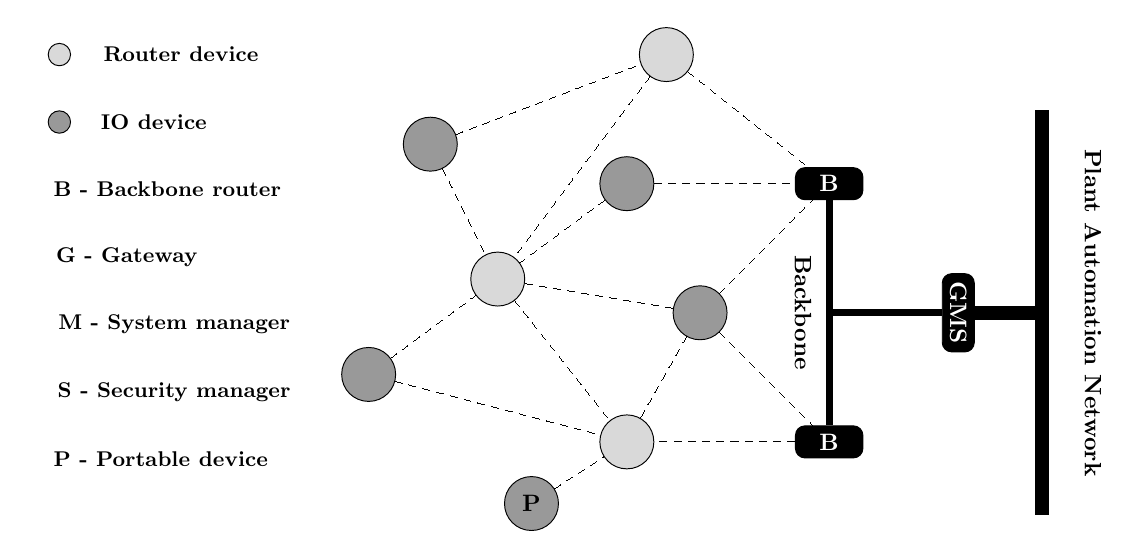
Figure 2. Typical ISA 100.11a